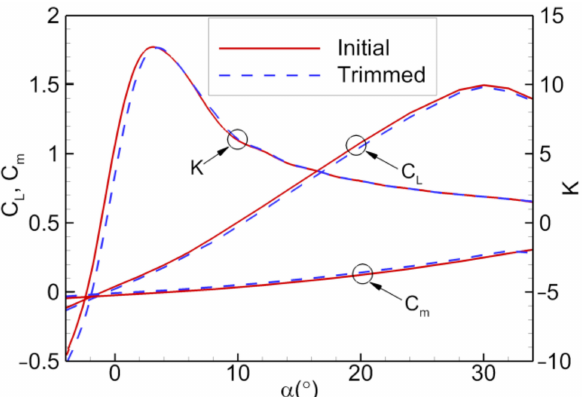
Figure 34. Aerodynamic characteristic of the trimmed configurations at low-speed state. Ma = 0.2, H = 0 km, α = − 4 ◦ ∼ 34 ◦ , ∆ α = 2 ◦ .